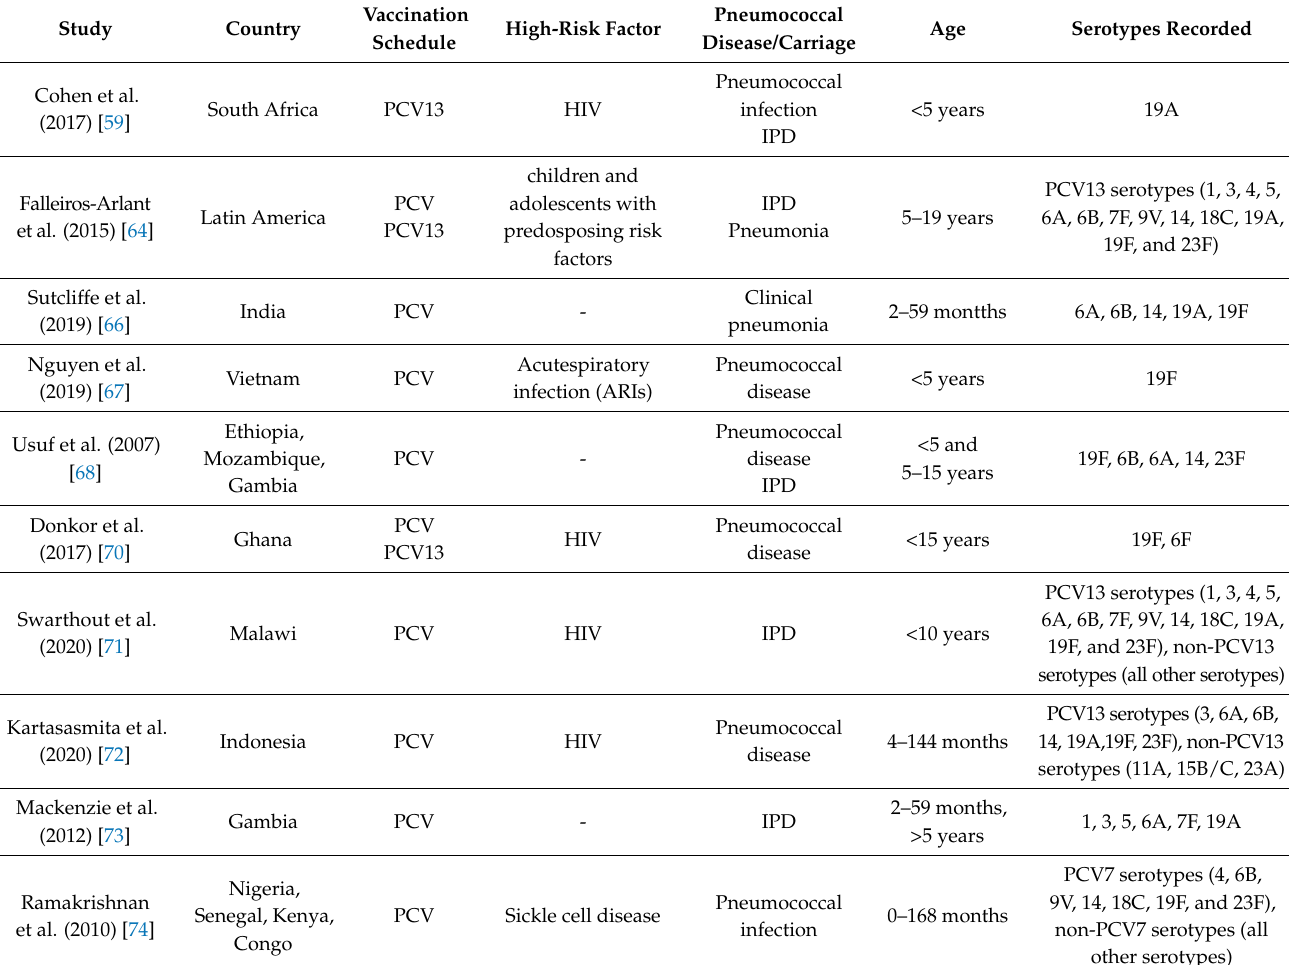
Table 3. Summary of studies showing the pneumococcal disease serotype epidemiology among pediatric populations at risk in the developing world. Pneumococcal Vaccination Age Serotypes High-Risk Factor Disease/Carriage